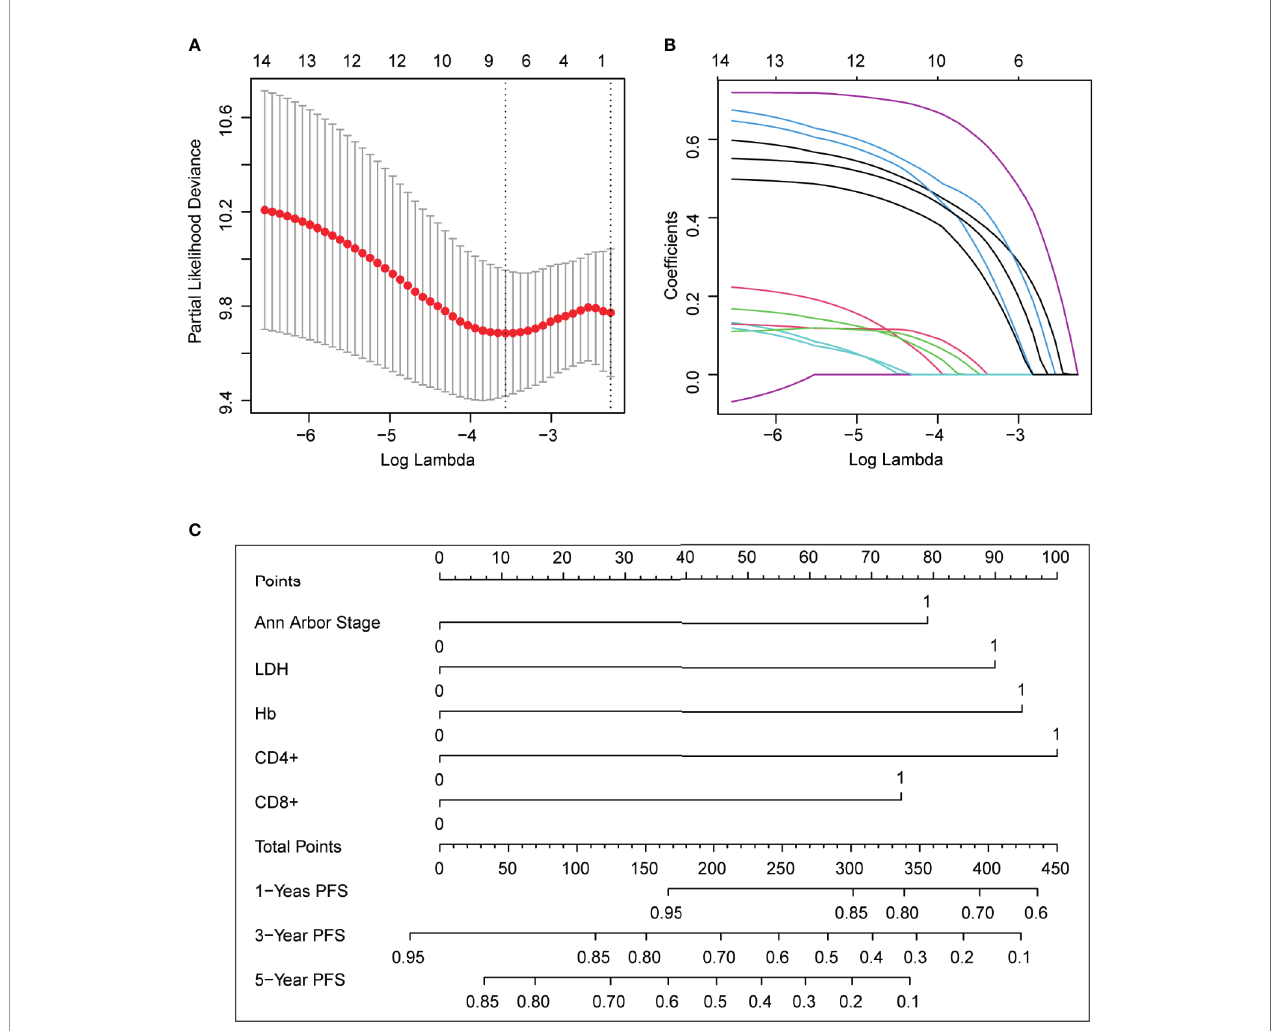
FIGURE 2 | The predictive factors were selected using LASSO regression analysis and nomogram construction. (A) Screening for tuning parameter (lambda) in the LASSO regression model. The partial likelihood deviance was calculated as a function of log (lambda), with the least deviance in partial probability corresponding to the optimal number of variables. The dotted vertical lines represented the optimal lambda value on the basis of 1 standard error and the minimum criteria. (B) The pro fi les of LASSO coef fi cient of the non-zero variables of FL patients. When 8 variables remained, the lowest partial probability deviance was observed. (C) For using the nomogram, place the value assigned to the individual patient on each variable axis, and draw an upward line for the determination of the number of points received for each variable value. The sum of these numbers is obtained on the total points axis, and a line is drawn down to the survival axis to calculate the 1, 3, 5- year PFS likelihood. LDH, lactate dehydrogenase; PFS, progression-free